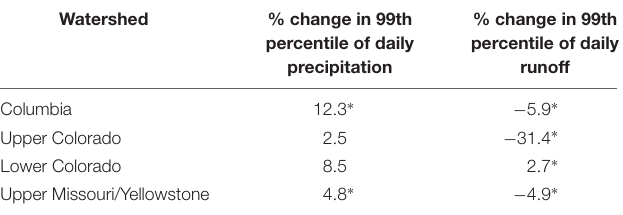
TABLE 2 | Percent change by end-century in daily precipitation and runoff percentiles for western watersheds. Watershed